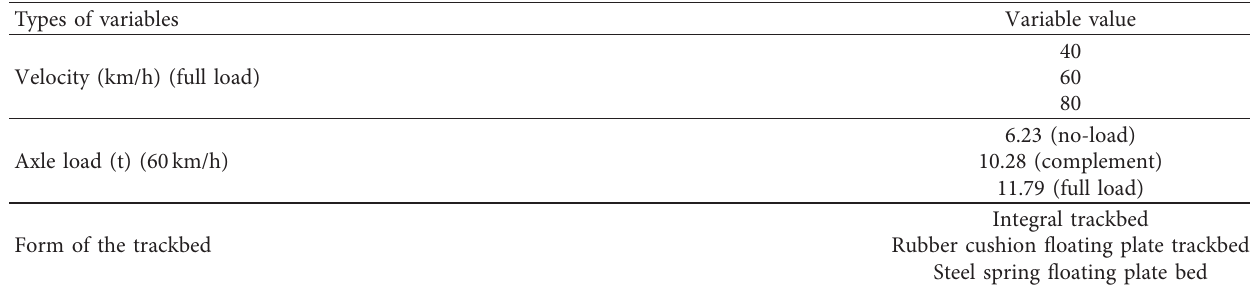
Table 8: Simulation